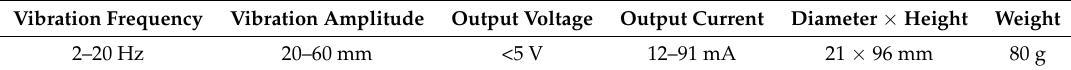
Table 2. The product parameters of the vibration